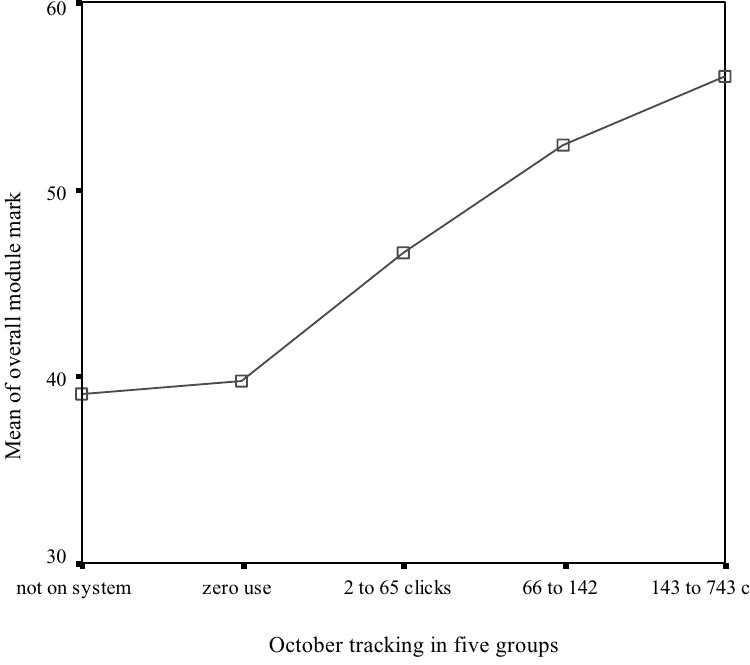
Figure 3. The value of early tracking data for MOB